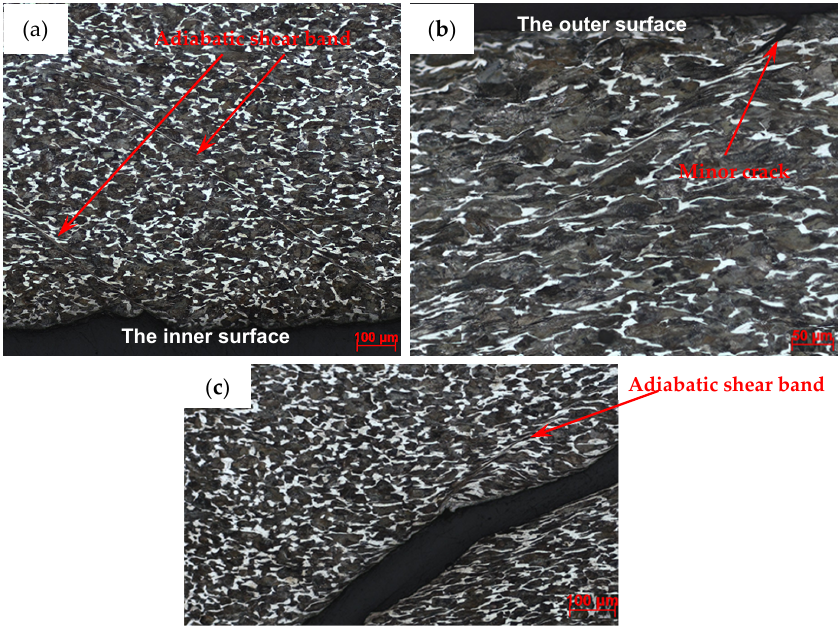
Figure 8. Typical results of optical microscope for Specimen 1#. ( a ) Multiple adiabatic shear bands near the inner surface; ( b ) minor crack near the outer surface; ( c ) adiabatic shear band within the crack, which is the magnified region of the red circle in Figure 7d.